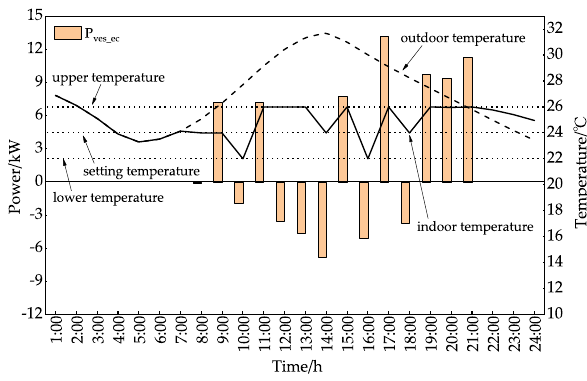
Figure 9. The ACVES charging/discharging power and indoor/outdoor temperature.